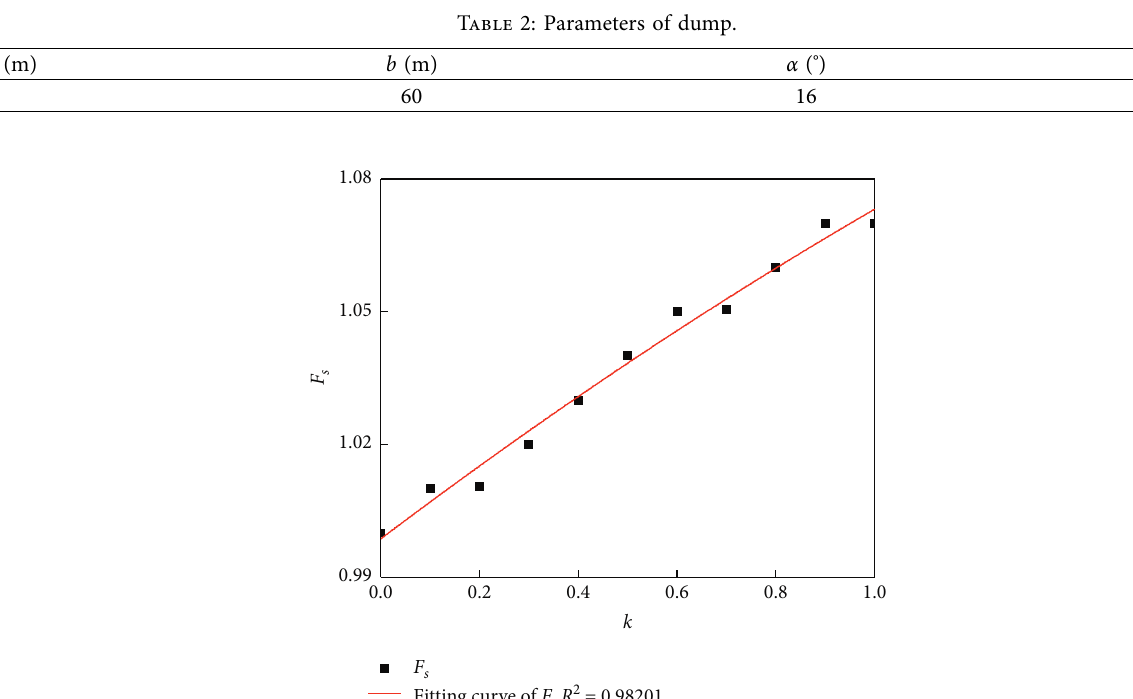
S with different k